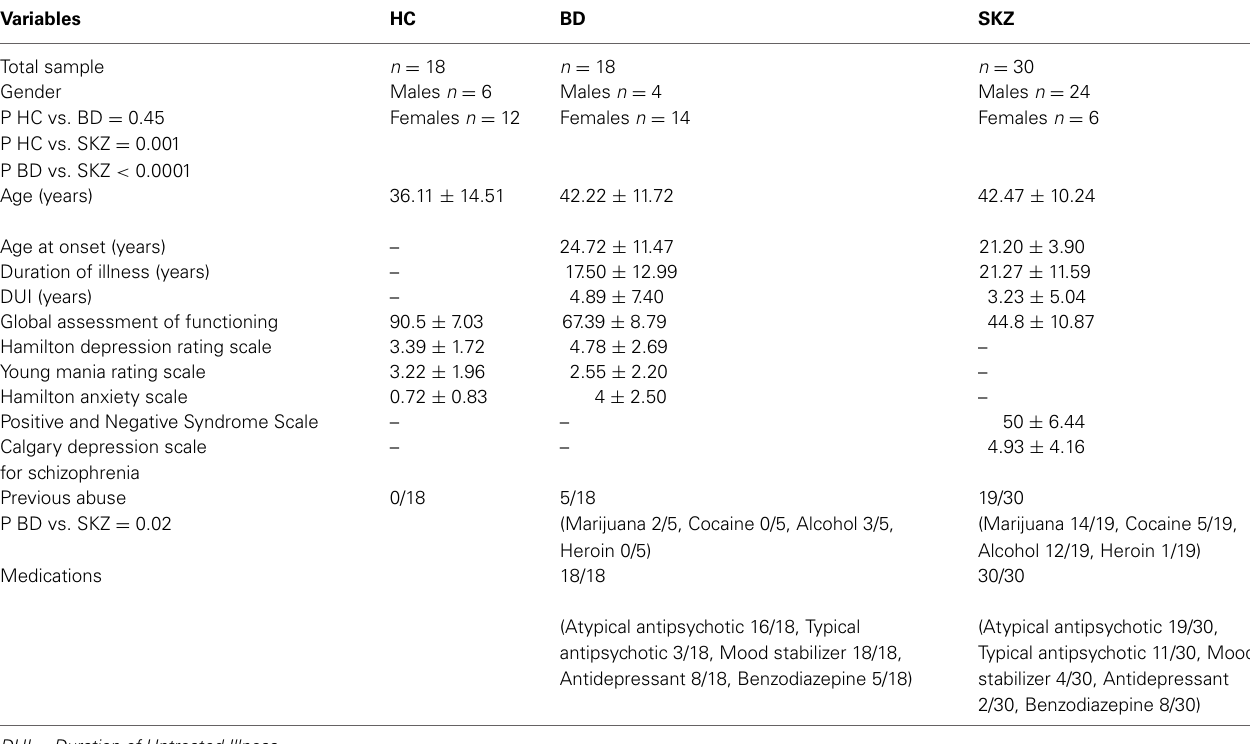
Table 1 | Differences between healthy controls (HC), bipolar disorder (BD) and schizophrenia (SKZ) patients in demographic and clinical measures.